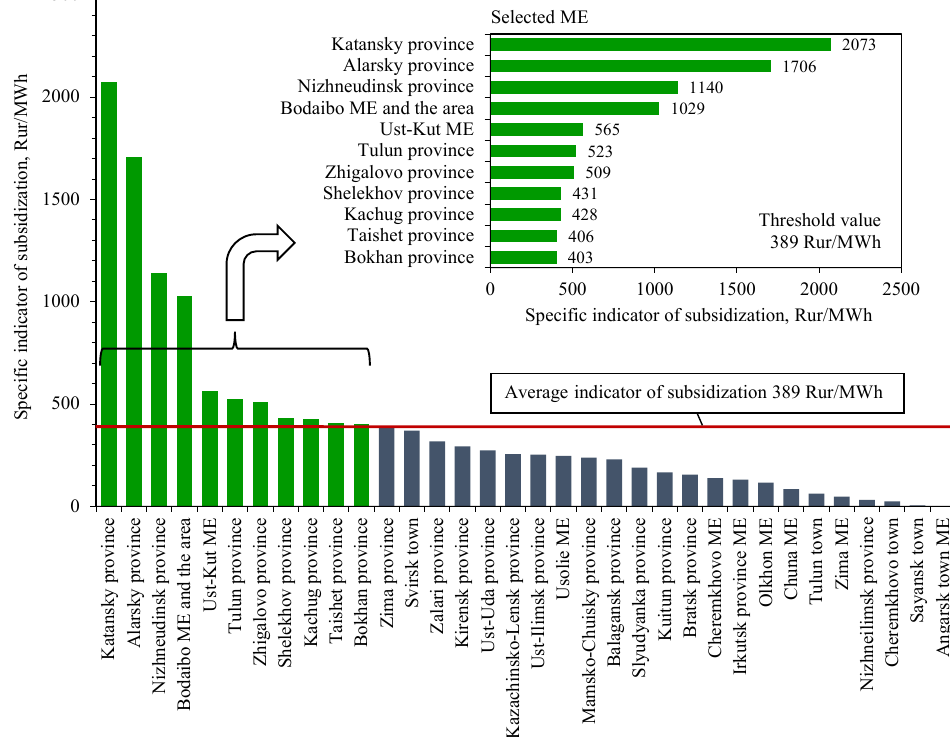
Fig. 3. Indicator of volumes of state subsidies of MU in the Irkutsk